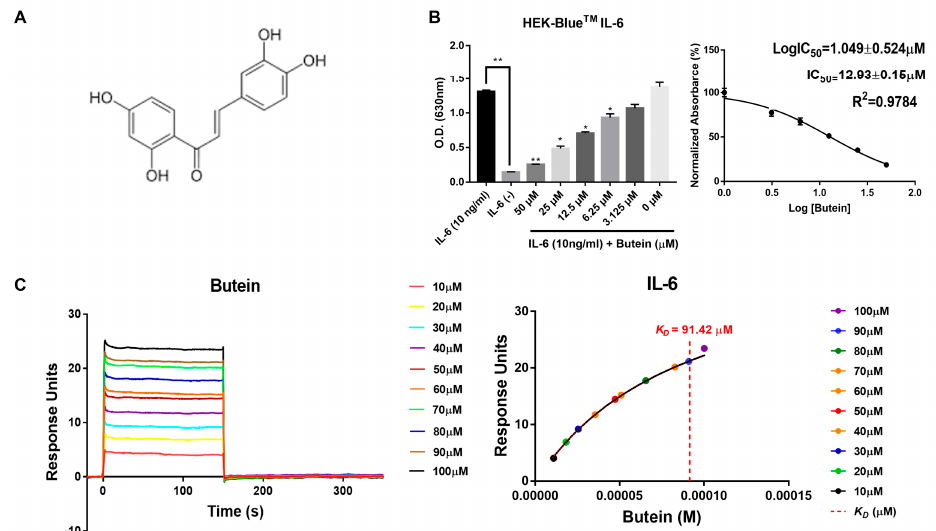
Figure 2. Characterization of butein and its anti-IL-6 activity in vitro. ( A ) Chemical structure of butein. ( B ) HEK-Blue™ IL-6 cells were treated with various concentration of butein for 24 h. The activation of IL-6 was measured by a SEAP activity assay after the treatment of HEK-Blue™ IL-6 cells with the different indicated concentrations of butein for 1 h in the presence or absence of IL-6 for 24 h (* p < 0.05, ** p < 0.01). ( C ) For SPR analysis, IL-6 was immobilized on a CM5 sensor chip, and butein was injected into the flow cells. T-200 BIAevaluation software (v3.0) was used to subtract the references and determine the steady-state KD. IL-6, interleukin 6.